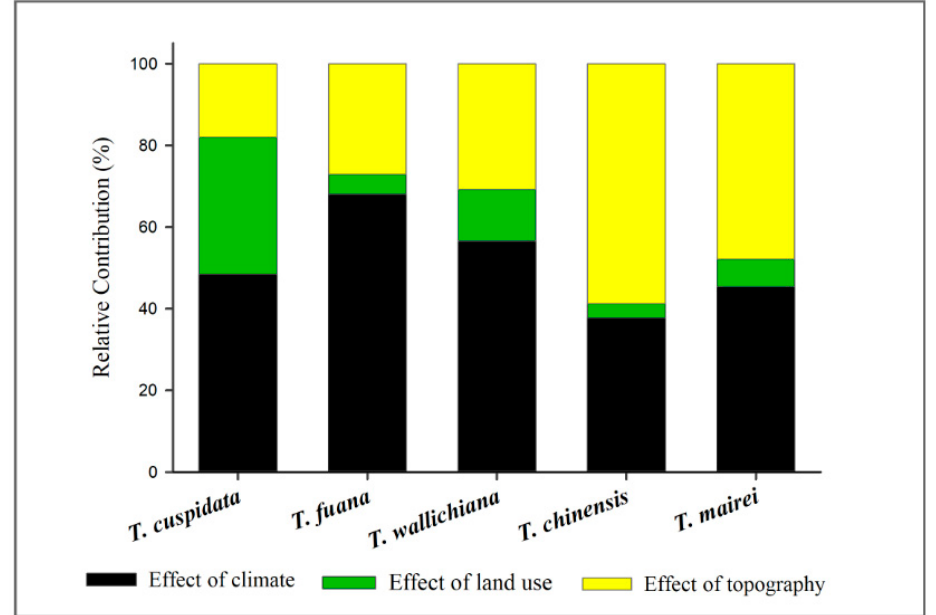
Figure 7. Relative effects of climate, land use, and topography on spatial distributions of each Taxus species, simulated by SDMs with the constraints of topography.